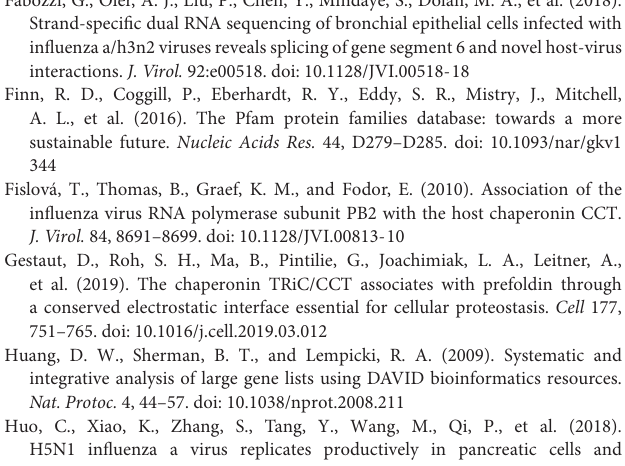
Supplementary Table 6 | Gene ontology enrichment of the target DEGs of DE-LncRNAs. Supplementary Table 7 | Common genes from dual RNA-seq and